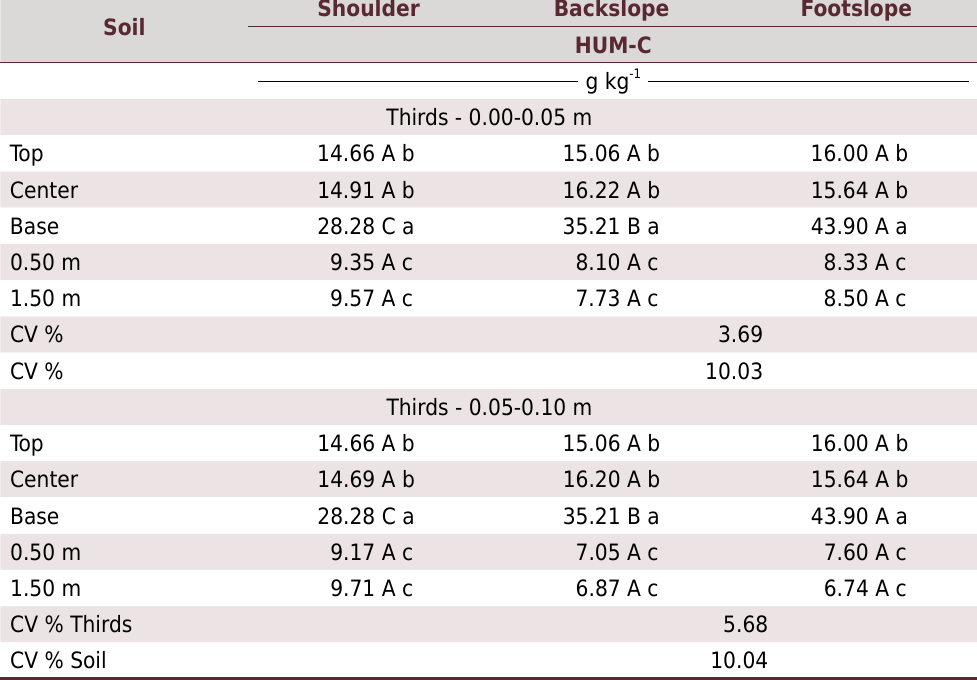
Table 8. Contents of carbon in the humin fraction (HUM-C) in termite mounds and adjacent soils in the Mar de Morros region, municipality of Pinheiral, Rio de Janeiro